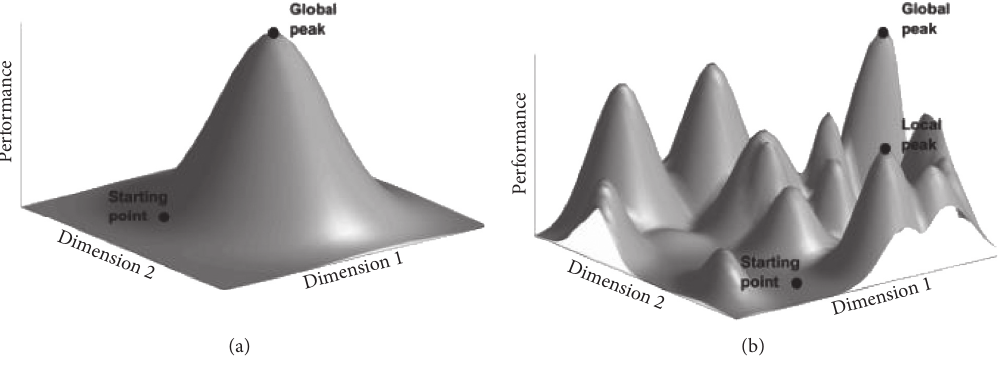
Figure 2: Stylized performance landscapes (from